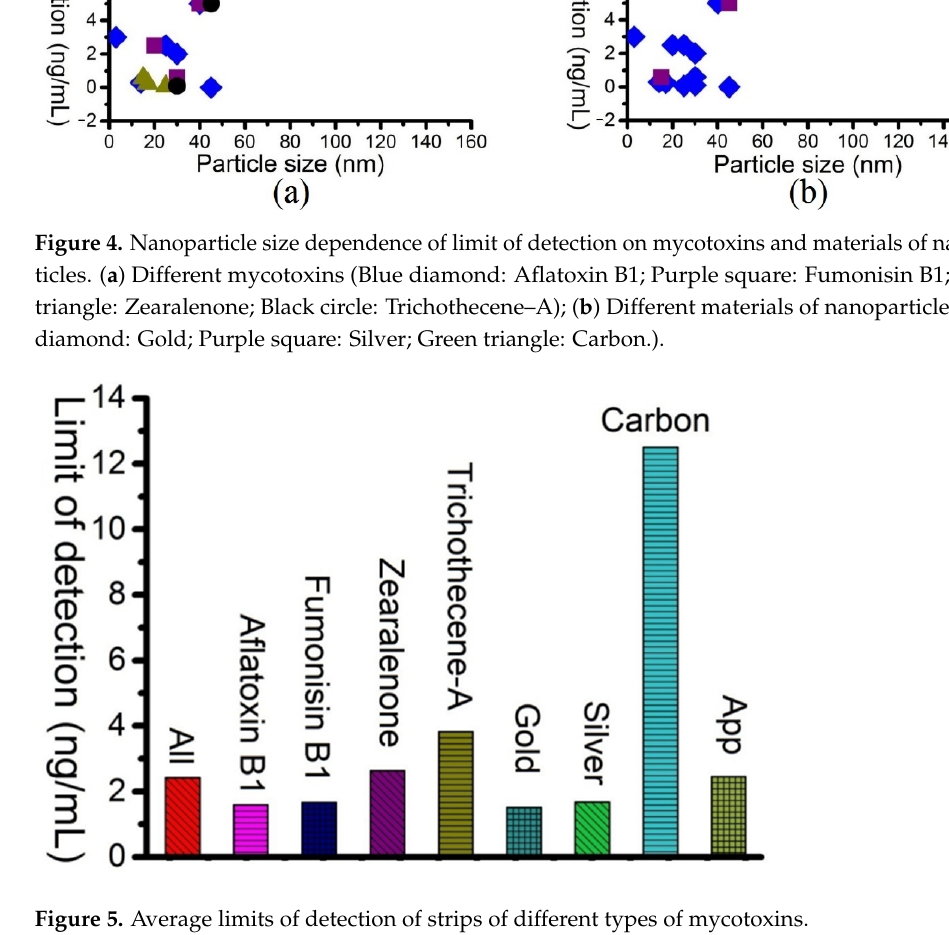
Figure 4. Nanoparticle size dependence of limit of detection on mycotoxins and materials of nano- particles. ( a ) Different mycotoxins (Blue diamond: Aflatoxin B1; Purple square: Fumonisin B1; Green triangle: Zearalenone; Black circle: Trichothecene–A); ( b ) Different materials of nanoparticles (Blue diamond: Gold; Purple square: Silver; Green triangle: Carbon.).